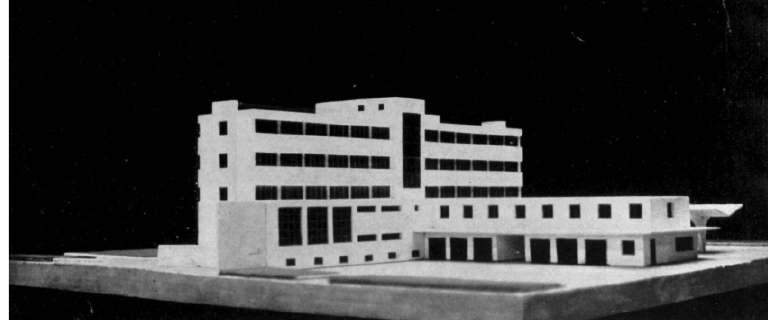
Figure 1. Model for hotel for auto tourists project, 1923, by Gabriel Guévrékian. Source: Gropius (2019, p. 50).